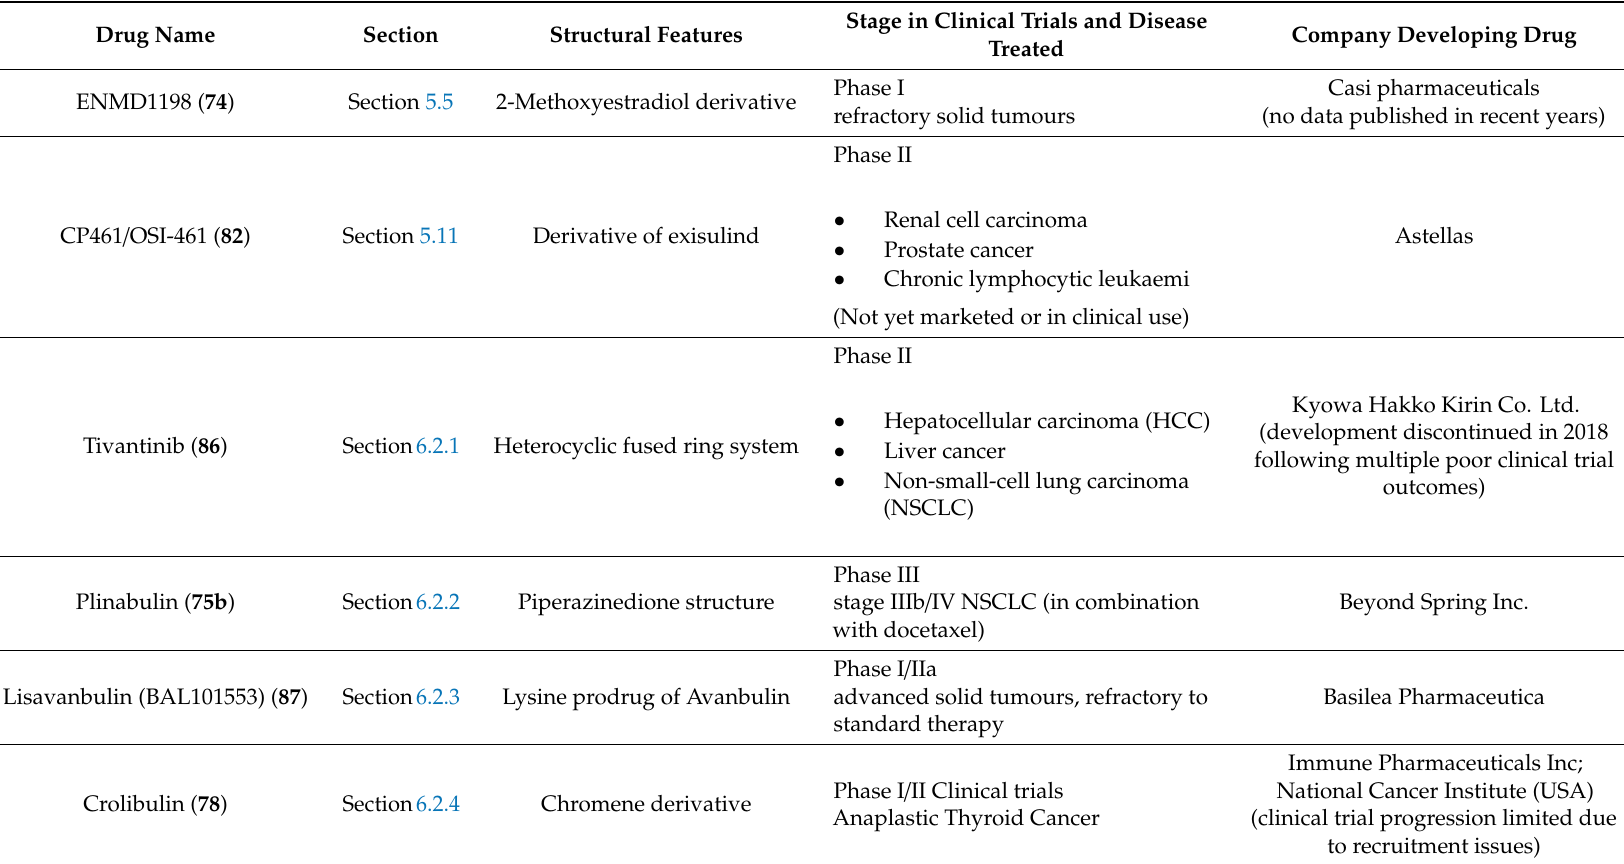
Table 1. CBSIs in clinical trials and clinical use—non combretastatin A-4